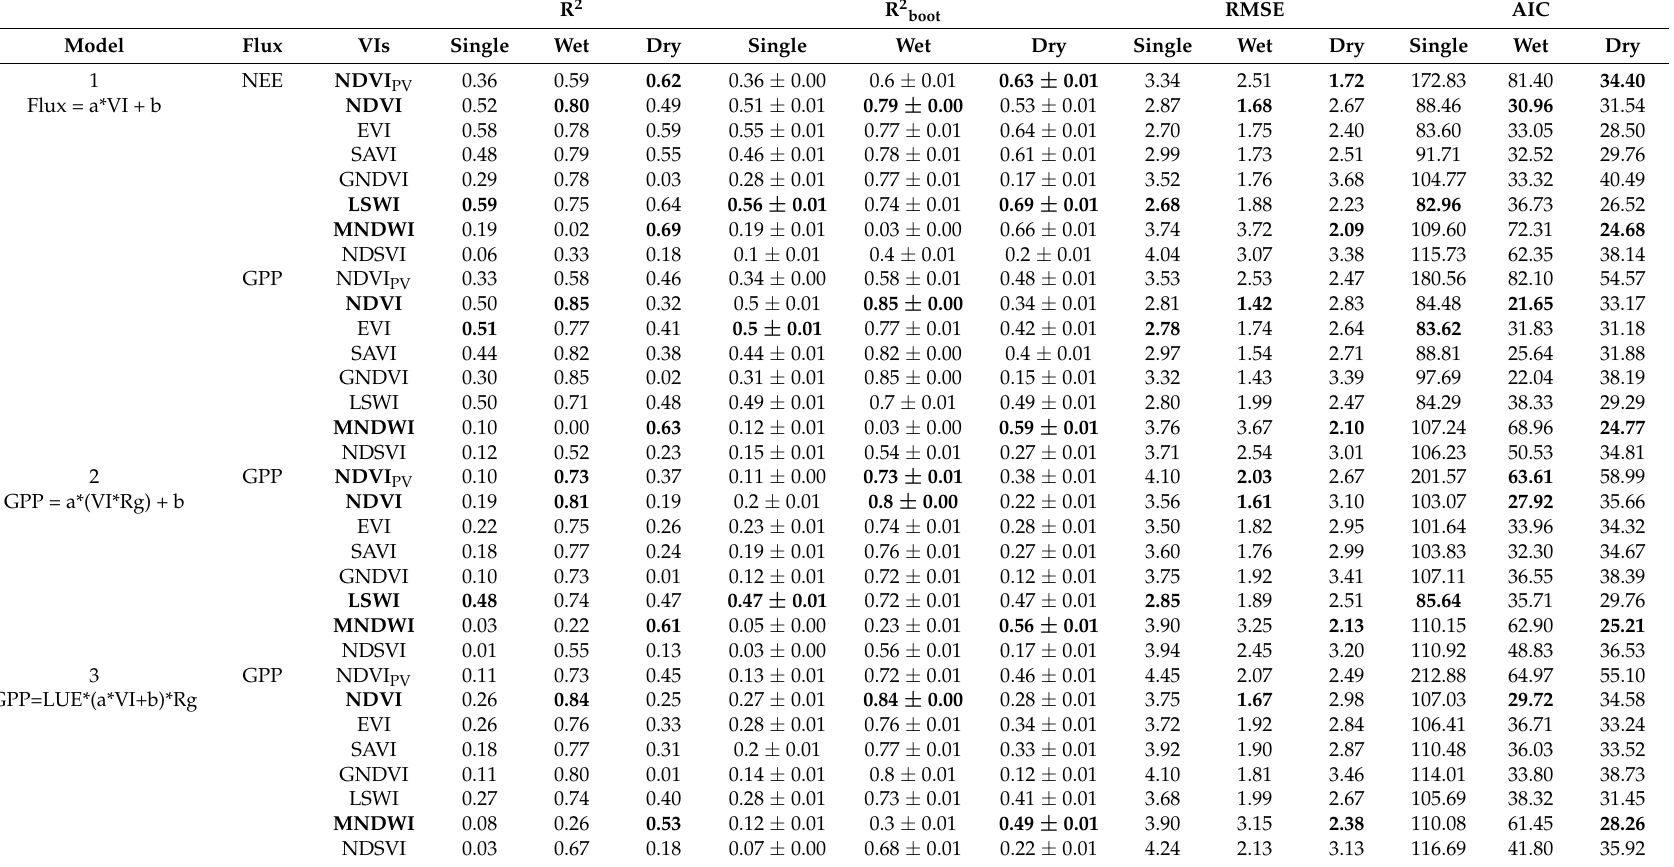
Table 3. GPP~VIs and NEE~VIs regression accuracy metrics (R 2 , R 2 boot , RMSE, AIC) obtained using only midday